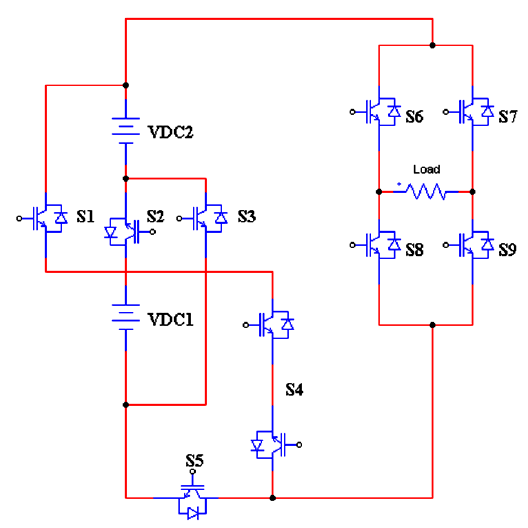
Figure 20. Nine-level inverter circuit.